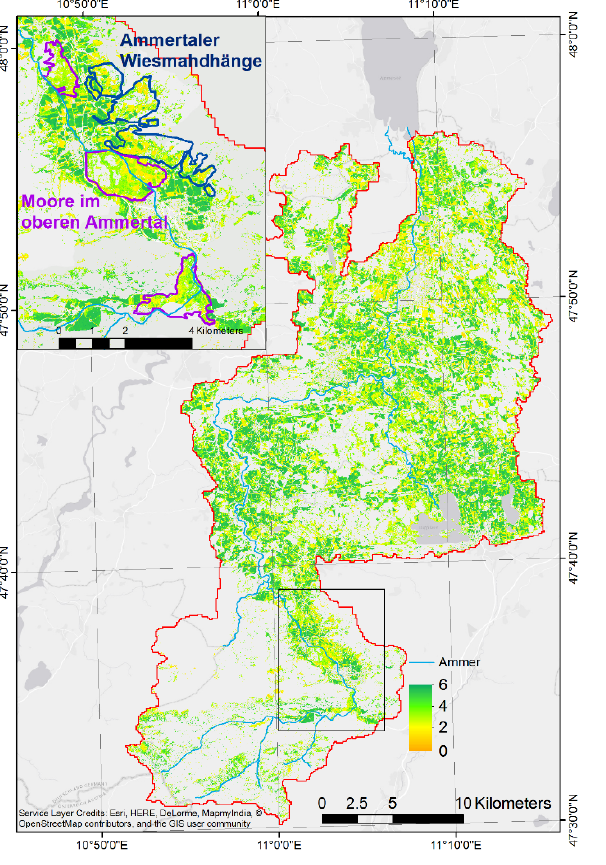
Figure 3. Grassland LAI in the Ammer catchment on September 6, 2011 including a zoom on the grassland sites in the Ammer valley with the Natura 2000 habitats hay meadows (orange outline) and moors (purple outline). distinctively lower LAI values.